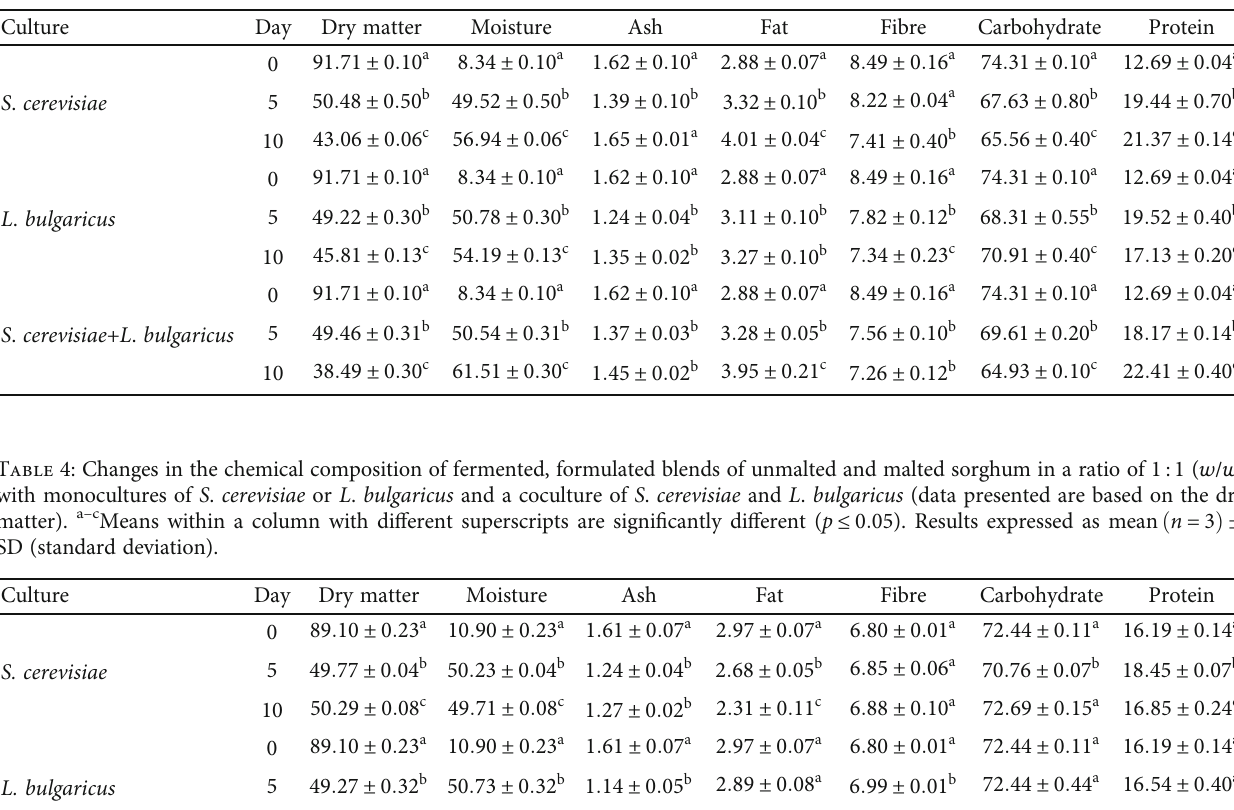
Table 3: Changes in the chemical composition of fermented, malted sorghum with monocultures of S . cerevisiae or L . bulgaricus and a coculture of S . cerevisiae and L . bulgaricus (data presented are based on the dry matter). a – c Means within a column with di ff erent superscripts are signi fi cantly di ff erent ( p ≤ 0 : 05 ). Results expressed as mean ð n = 3 Þ ± SD (standard deviation).